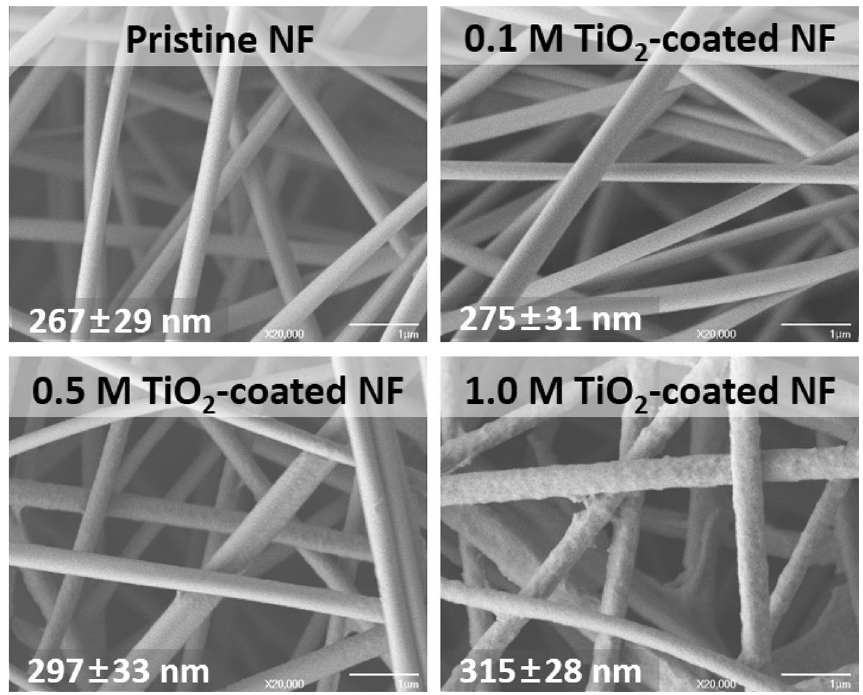
Figure 1. FE-SEM micrographs of YSZ/silica and TiO 2 -coated YSZ/silica NF: pristine NF, 0.1 M TiO 2 -coated NF, 0.5 M TiO 2 -coated NF and 1.0 M TiO 2 -coated NF.